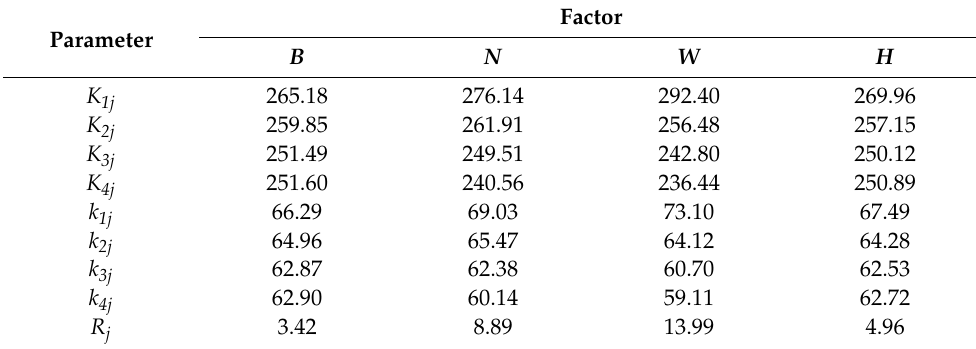
Table 5. The range analysis of the maximum